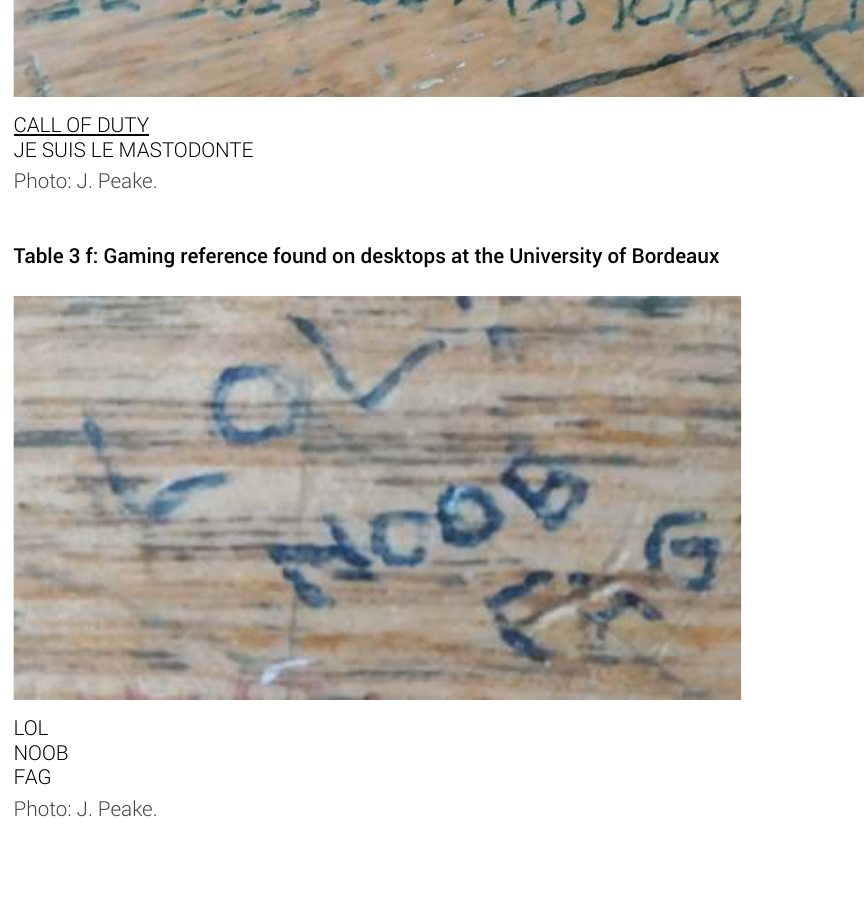
CALL OF DUTY JE SUIS LE MASTODONTE Photo: J. Peake.